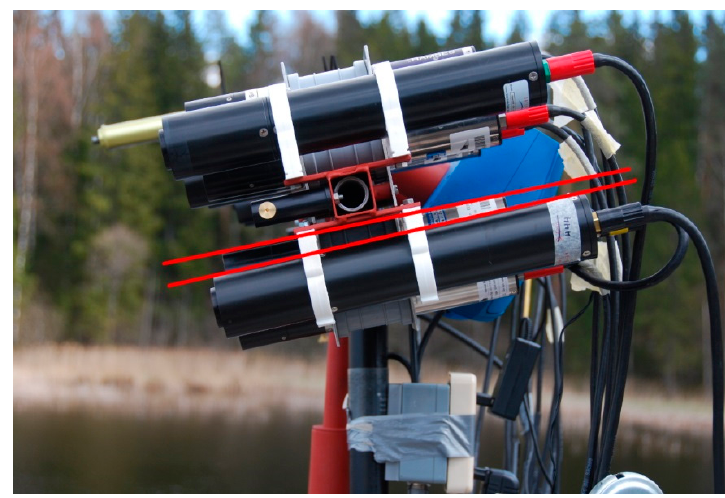
Figure 8. The angle between red lines marking the directions of HyperOCR and RAMSES sensors was measured to be 1.3° from this image.